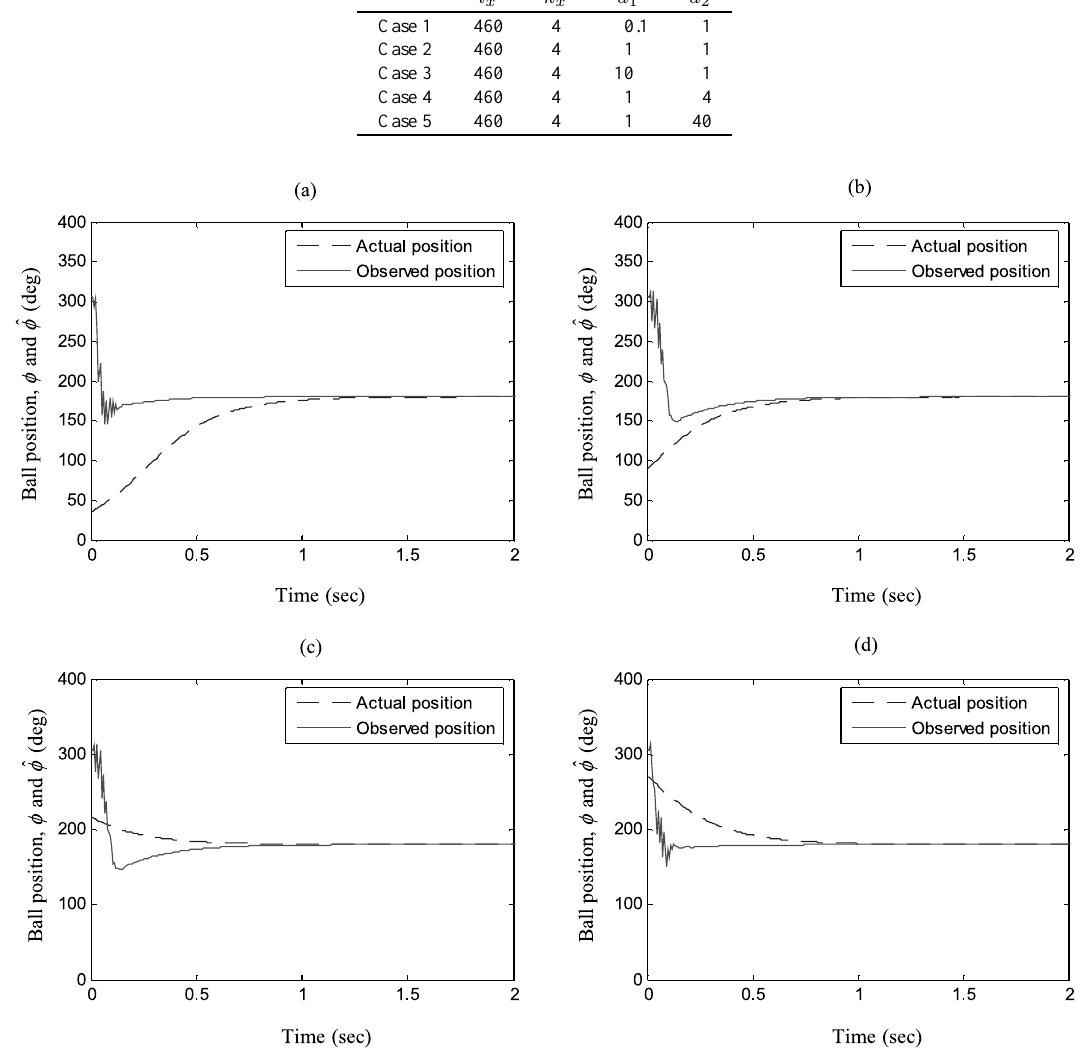
Fig. 8. Observed ball position based on the designed sliding-mode ball observer with l x = 460, k x = 4, a 1 = 0.1, a 2 = 1 and initial ball position at (a) 36 ◦ , (b) 90 ◦ , (c) 216 ◦ and (d) 270 ◦